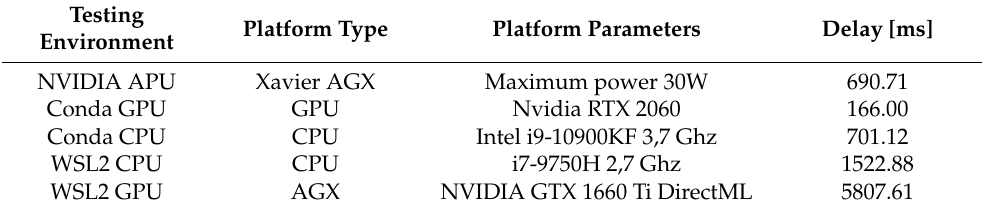
Table 3. The acquired inference results for the Mask CNN model.